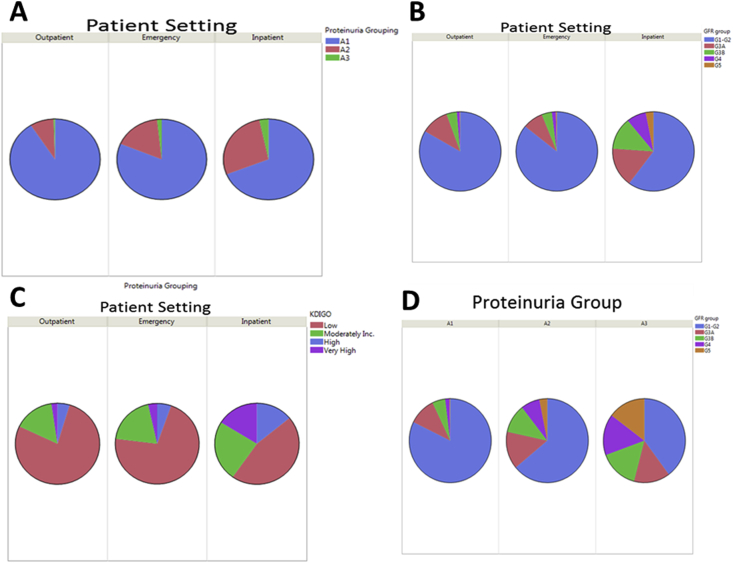
Associations between proteinuria, GFR, KDIGO risk group, and clinical setting in which UA was performed. (A) Proteinuria Group, (B) GFR Group, and (C) KDIGO Risk Stratification by Patient Setting. (D) GFR Group Distribution by proteinuria group.